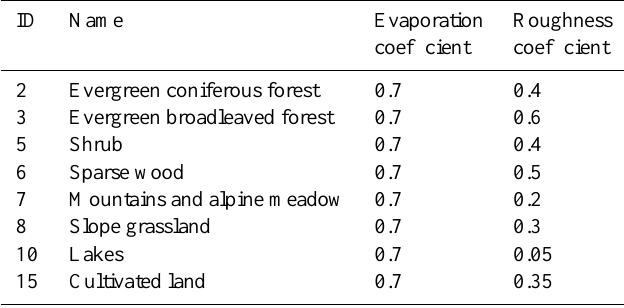
Table 2. Initial values of land-use-based parameters in UMWC.